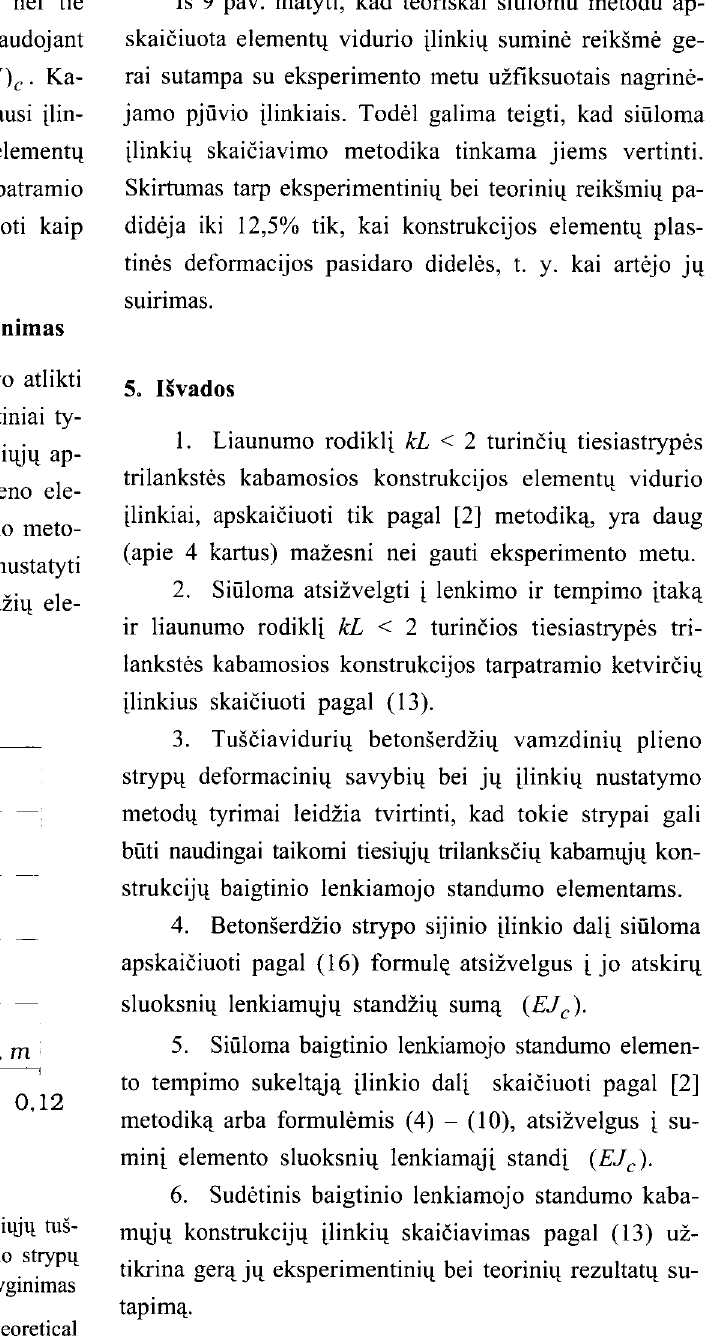
Fig 9. Comparison of the experimental and theoretical mid-span deflections of straight-line hollow concrete-fil led steel tubular members of three-hinge suspension